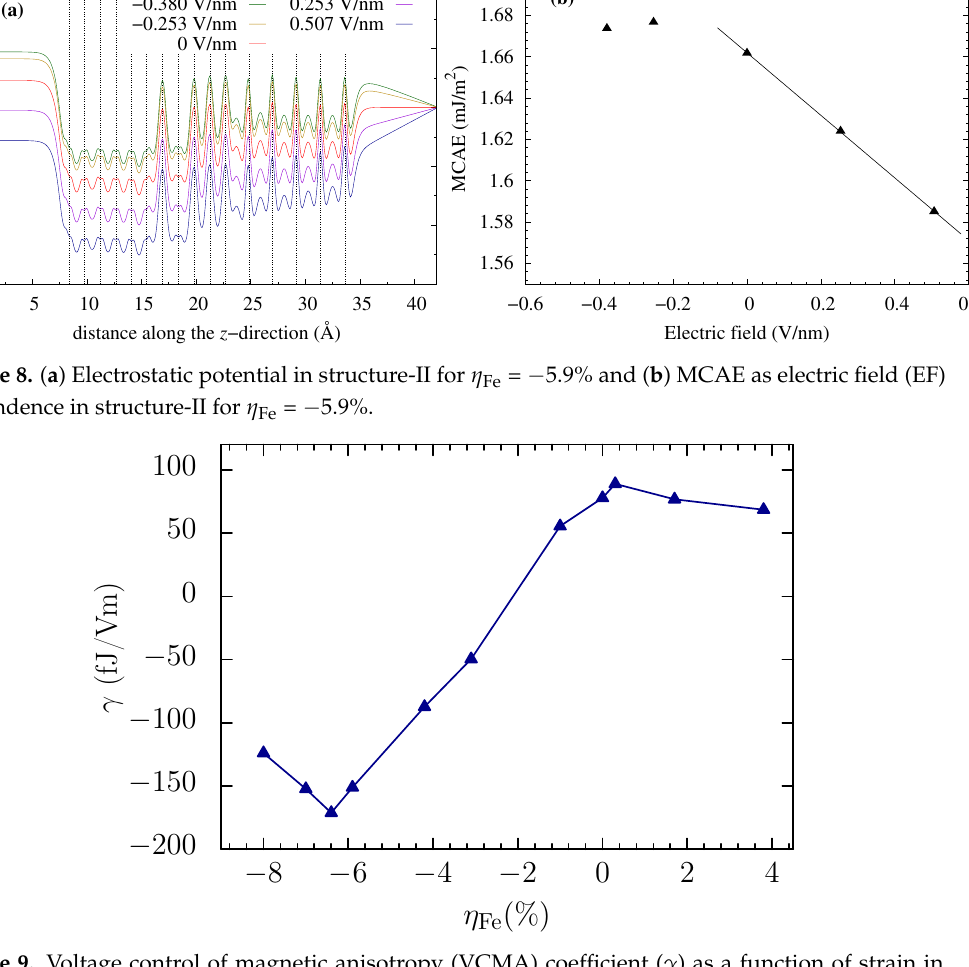
Figure 9. Voltage control of magnetic anisotropy (VCMA) coefficient ( γ ) as a function of strain in structure-II.